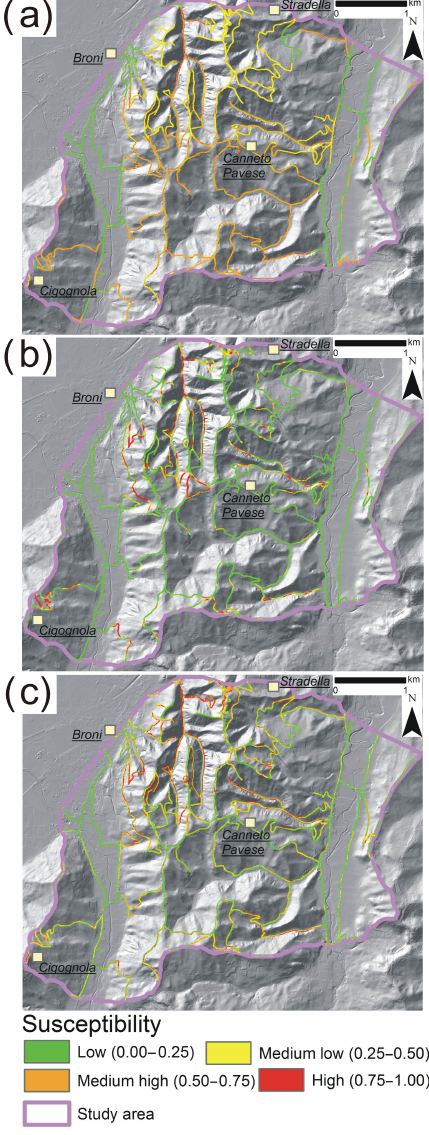
Figure 10. Maps of the susceptibility of the road segments to be af- fected by shallow landslides: (a) Model 1; (b) Model 2; (c) Model 3.